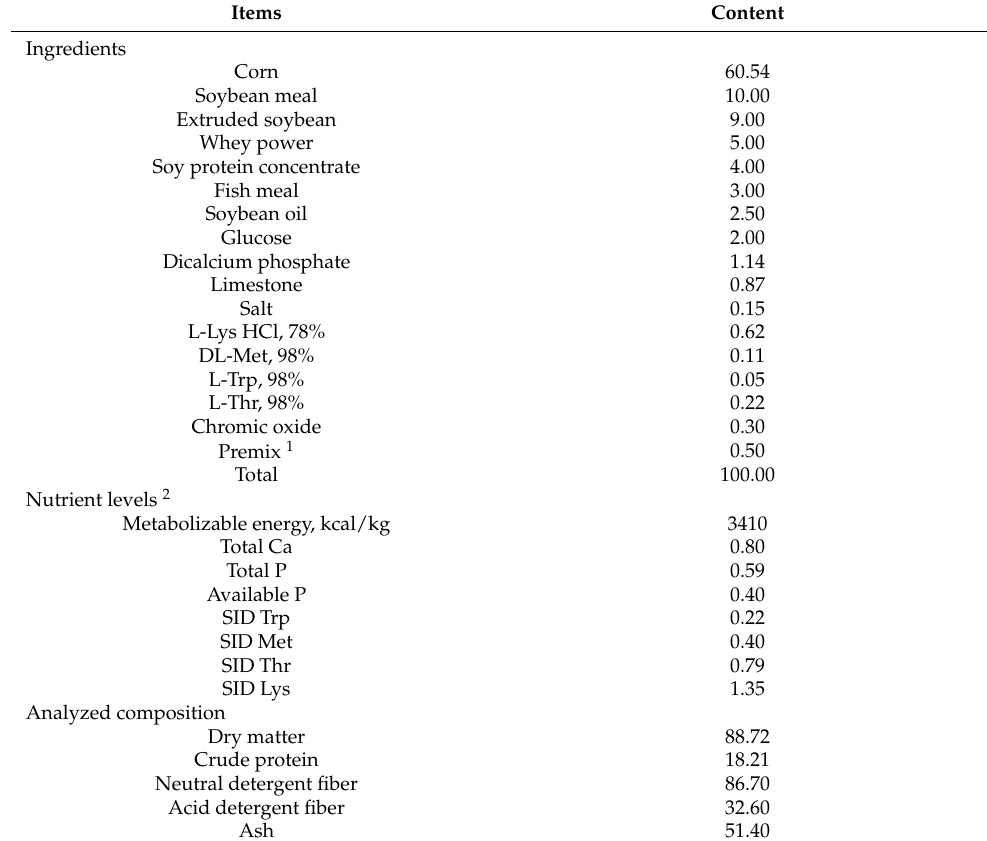
Table 1. Nutrient levels and composition of the basal diets (%, as-fed basis). Items